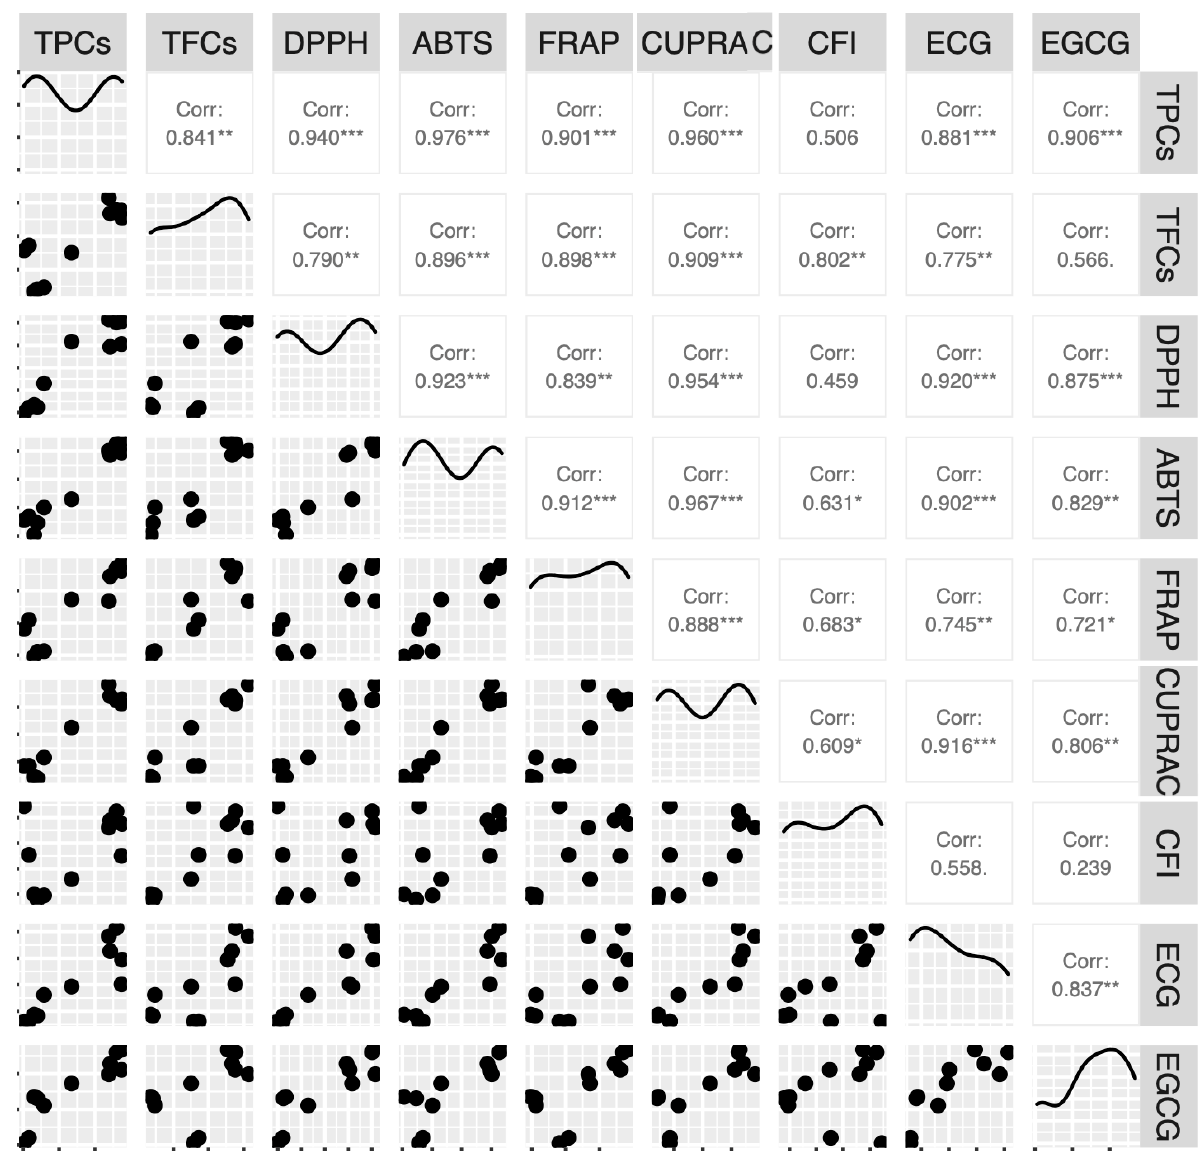
Figure 1. Pearson correlation coefficients among the determined parameters for dried tea products of different geographical origins and varieties in Vietnam. (Note: ***, **, * represent significance levels of 0.1%, 1%, 5%, respectively).